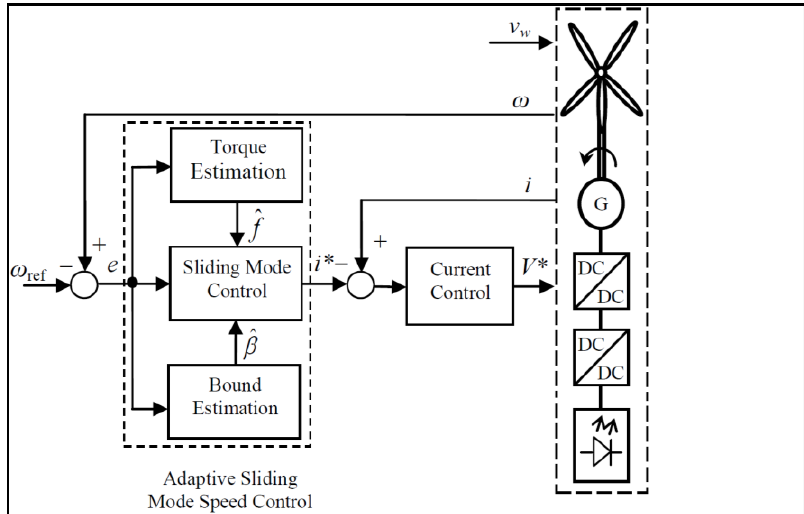
Figure 1. Adaptive sliding mode controller for the DC generator wind turbine.